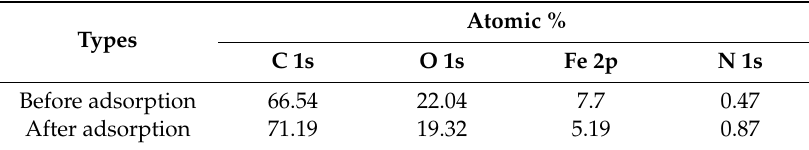
Figure 6. XPS spectra of: ( a ) the survey scan, and high-resolution scans of: ( b ) Fe2p, ( c ) C1s before adsorption, and ( d ) C 1s after adsorption. Table 1. Atomic percentages of C, O, Fe, and N.